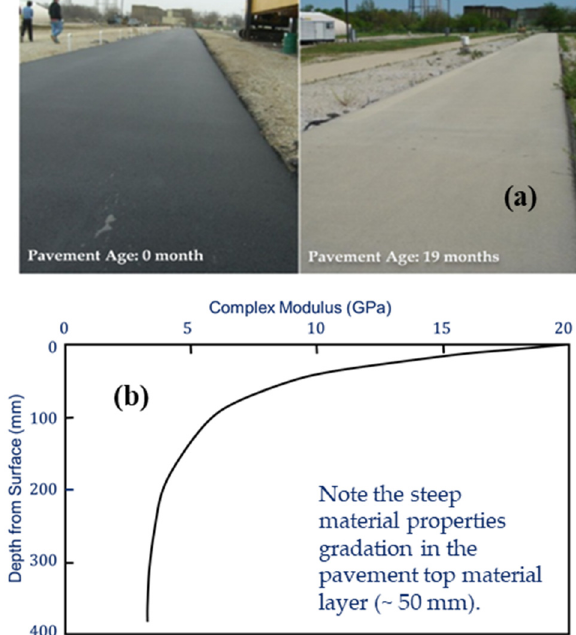
Figure 3. Oxidation of asphalt concrete pavements: ( a ) pavement section right after the construction (left), and the same pavement 19 months after construction (right); and ( b ) Schematic diagram illustrating the steep gradation of material properties (e.g., complex modulus) caused by oxidative aging at the pavement top material layer.